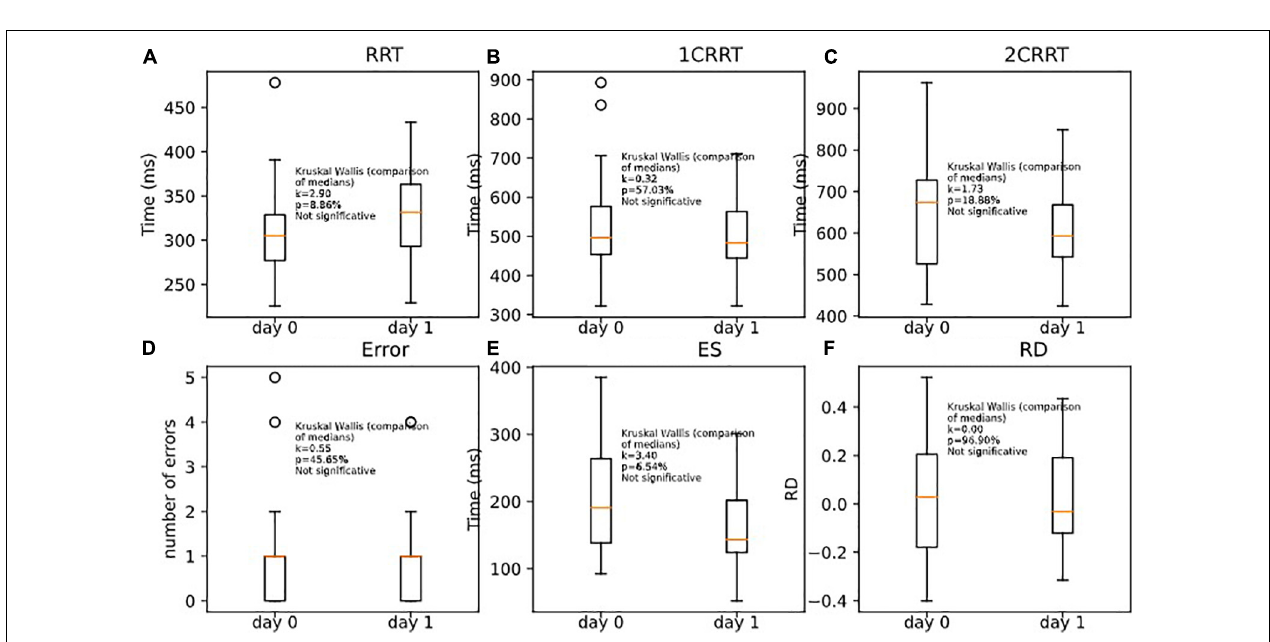
FIGURE 11 | Comparison of medians for re-tests effects on (A) RRT, (B) 1CRRT, (C) 2CRRT, (D) Errors, (E) ES, and (F) RD. Kruskal-Wallis test asserts that medians are not significantly different.